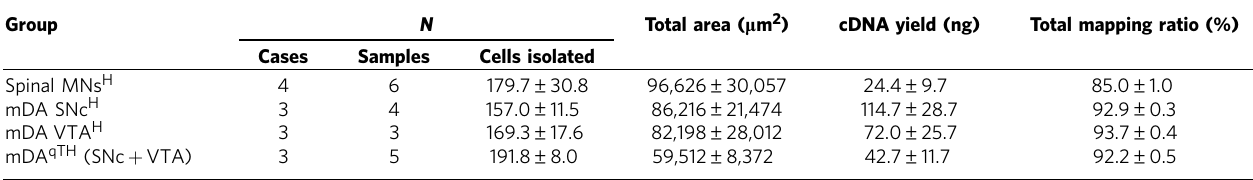
Table 2 | Details of human neuron samples and the corresponding LCM-seq libraries.